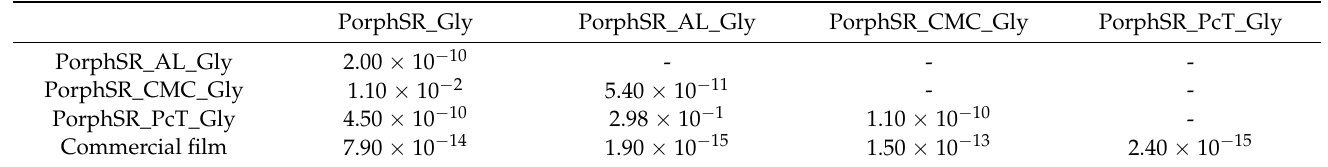
Table A2. Bonferroni pairwise comparison p -values for the different water vapor transmission rates.